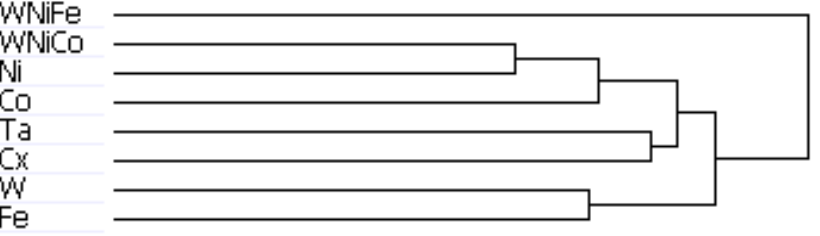
Figure 4. Dendrogram from hierarchal clustering analysis of rat microarray